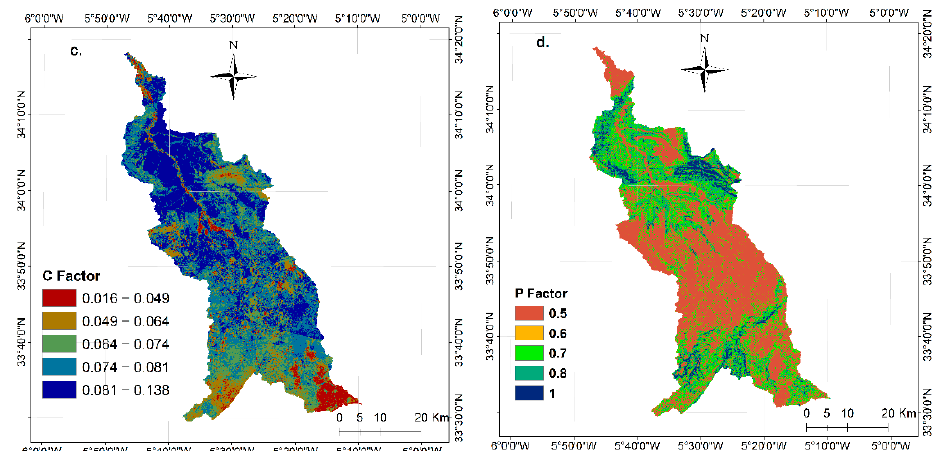
Figure 6. Spatial distribution of USLE parameters: ( a ) Slope Length (LS-factor); ( b ) Soil erodibility (K); ( c ) Crop and management; ( d ) Support practice factor (P) maps.